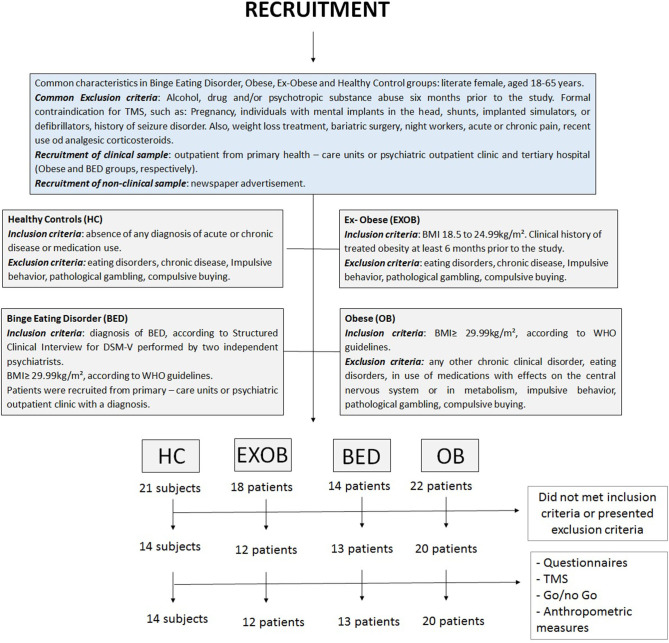
Flow of the study.